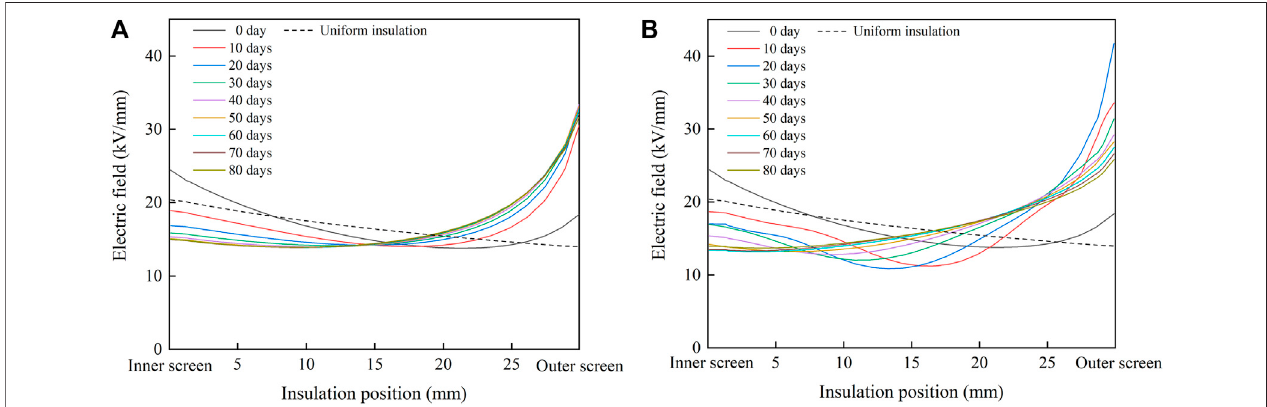
FIGURE 8 | Radial distribution of the electric fi eld in cable insulation. (A) Single well model; (B) double well model.